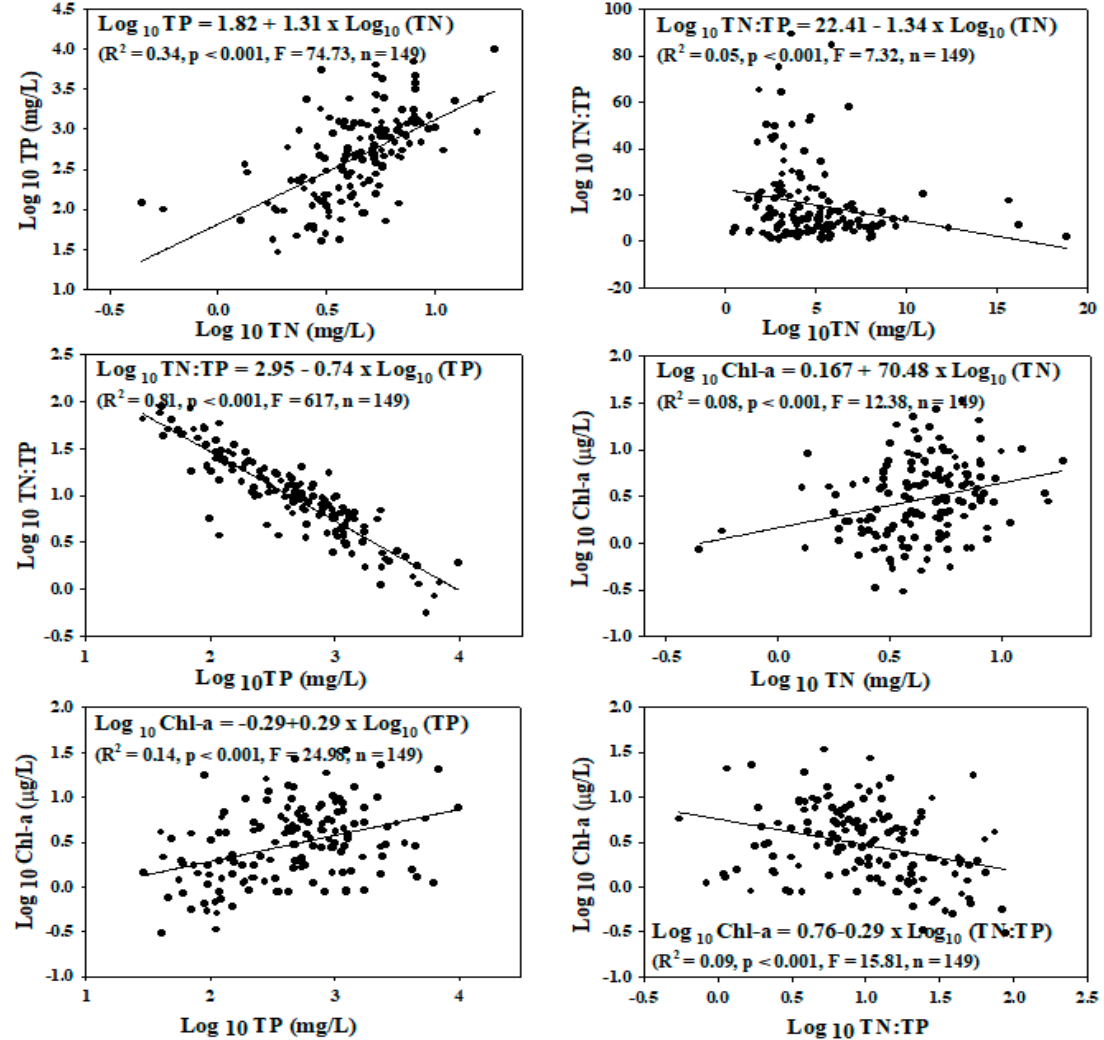
Figure 2. Regression relationship on CHL-a and nutrient contributing factors in Geum River watershed.